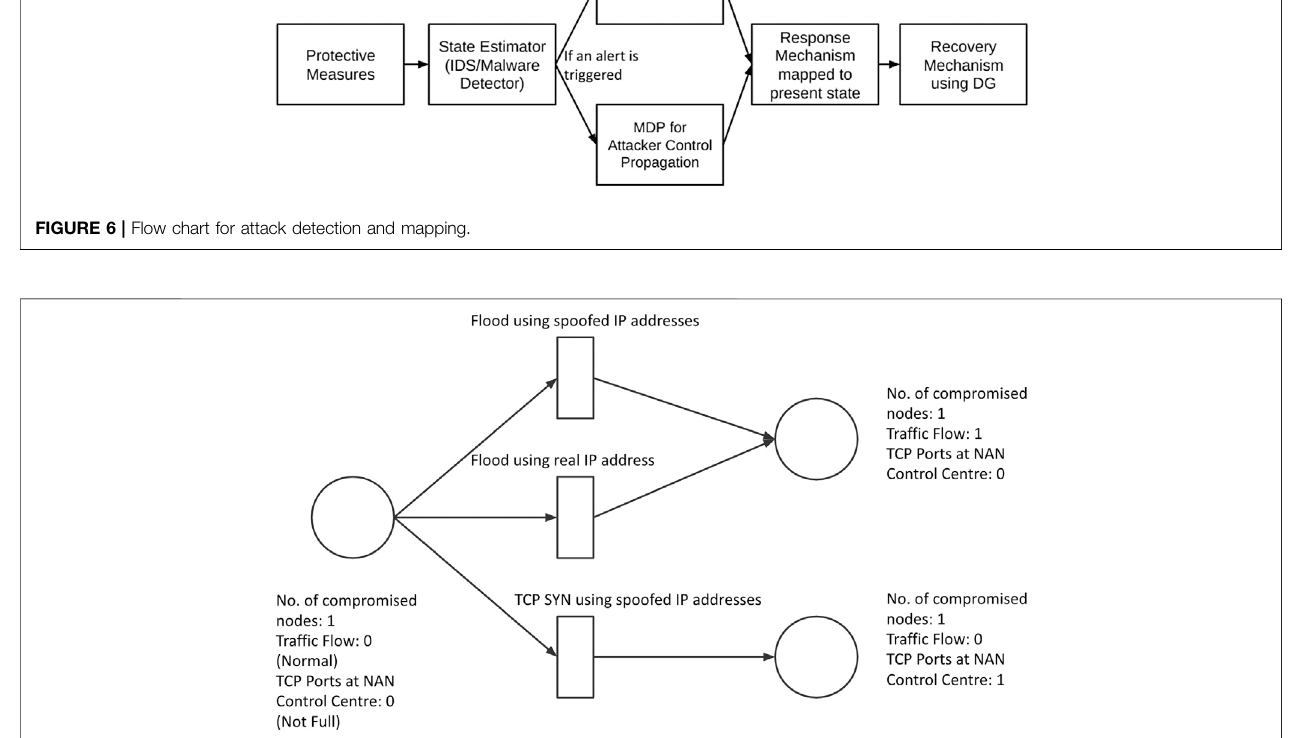
FIGURE 7 | DoS Attack Vector using Petri